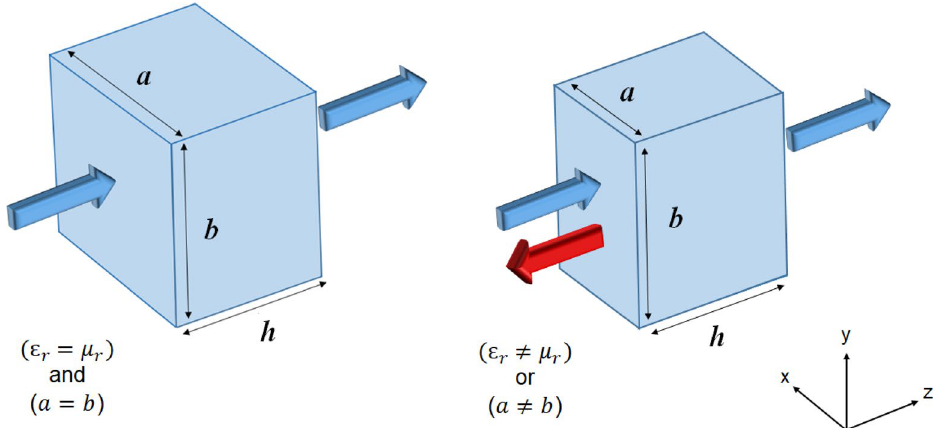
Figure 1. Two conditions that, together, are sufficient for ZBS: A rectangular prism of height h illuminated by a normally incident plane wave (propagating in the the prism base sides are equal a